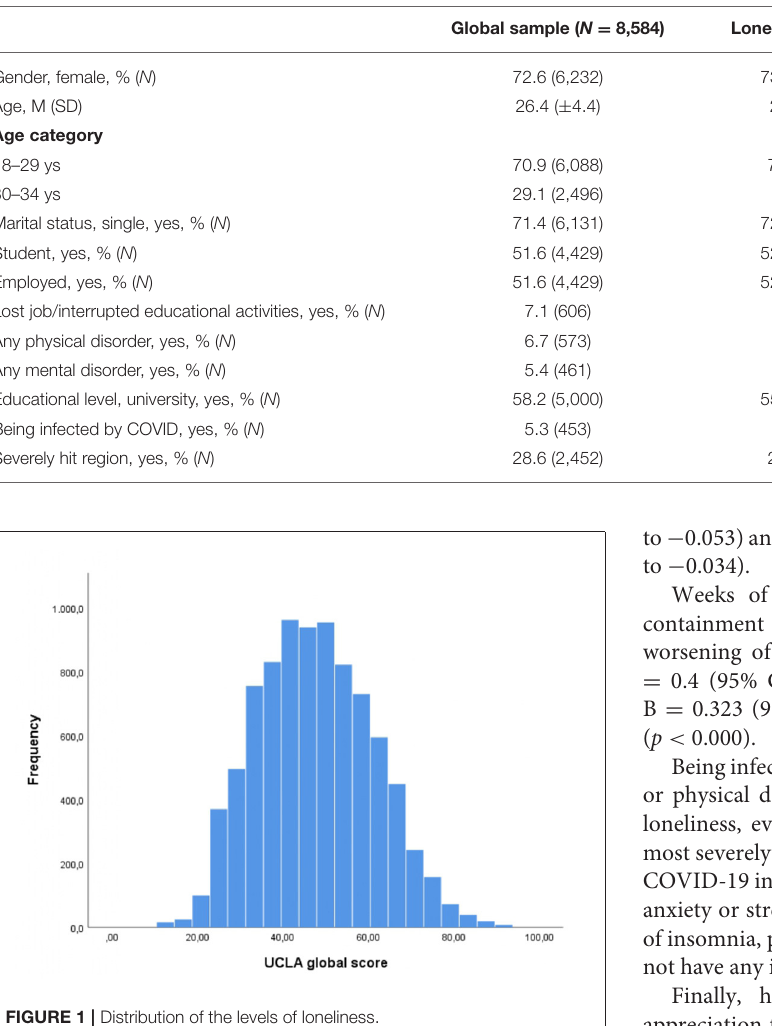
FIGURE 1 | Distribution of the levels of